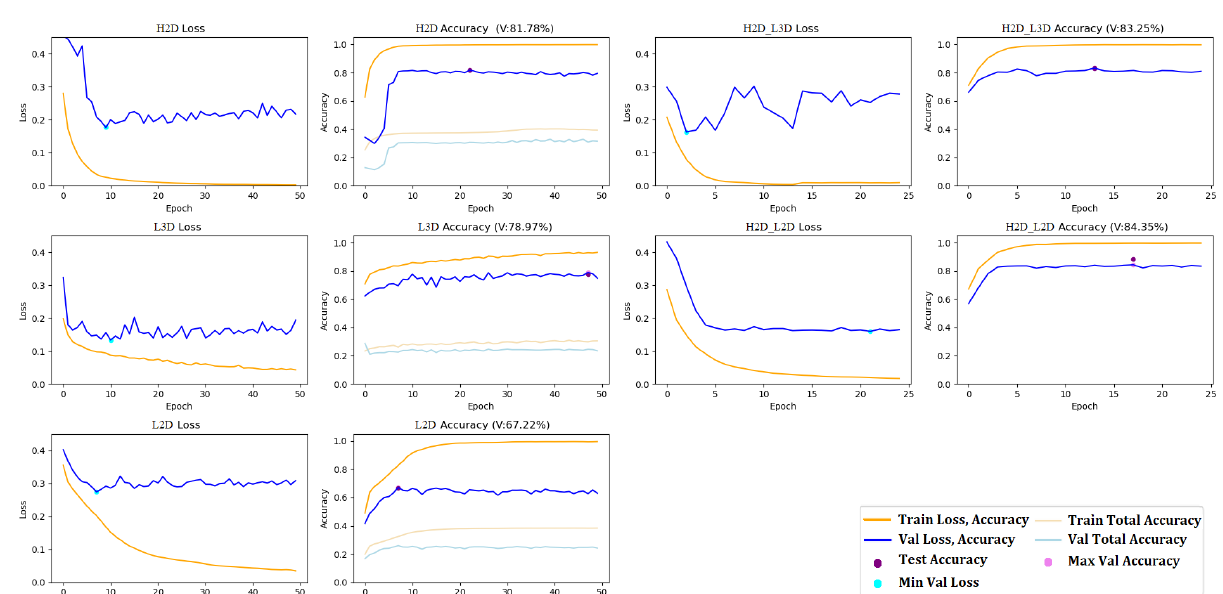
Figure A2. All model training histories. For each model, two plots are provided that depict the training and validation histories of the model loss and accuracy. The accuracy plots for unimodal networks also provide the accuracy against all pixel classes including unlabeled, in lighter color shading. Each loss plot labels, in purple, the minimum observed loss during training. Each accuracy plot labels the maximum observed validation accuracy, in orange, and that model’s test accuracy, in